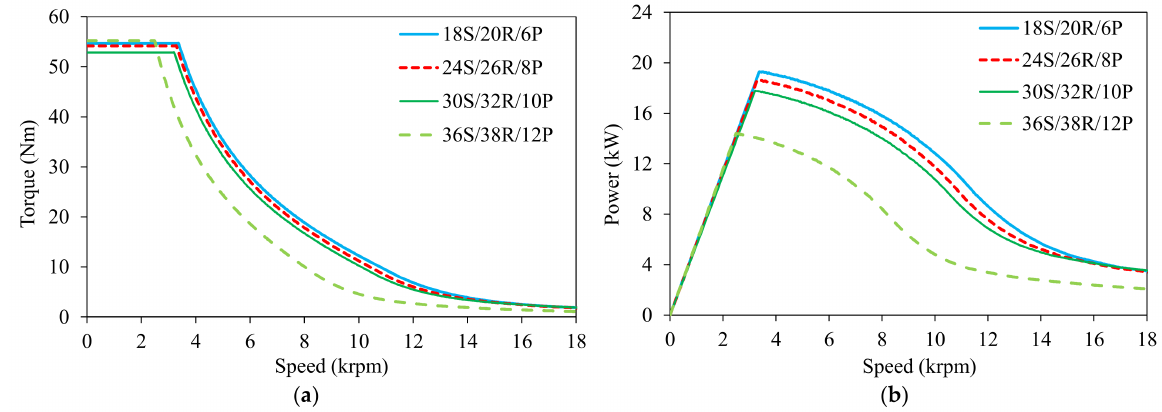
Figure 20. Flux-weakening performance comparison for 80 mm AIMs designed with different stator slot/rotor slot/pole number combinations: ( a ) torque-speed curve and ( b ) power-speed curve.